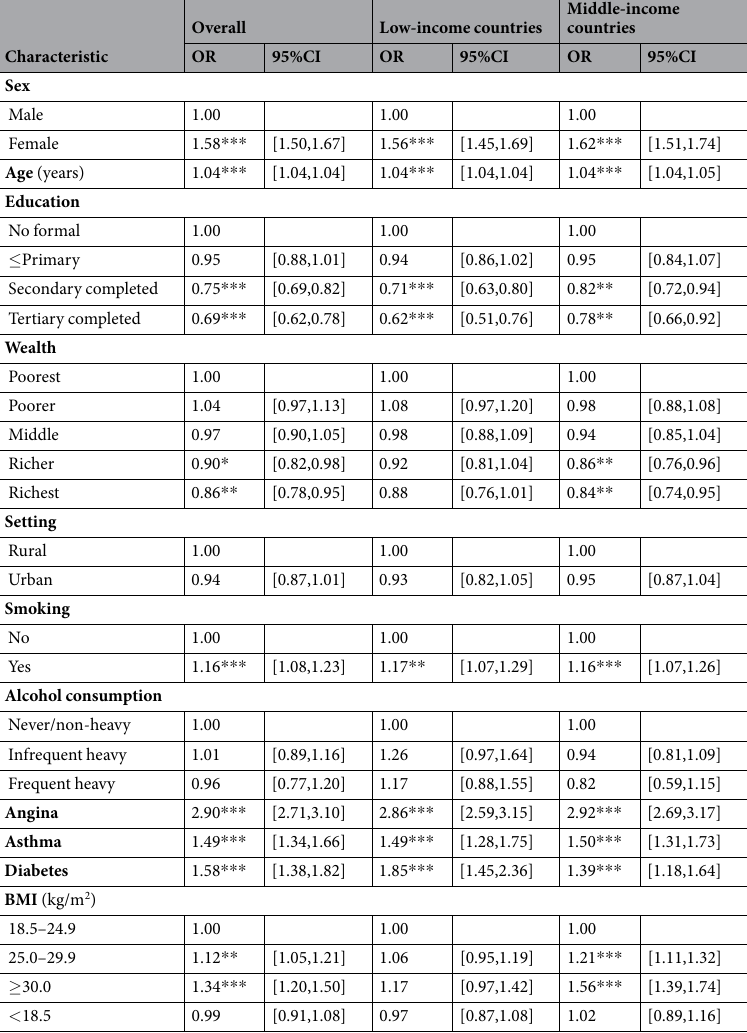
Table 3. Correlates of arthritis assessed by multivariable binary logistic regression analysis. Abbreviation: OR odds ratio; CI confidence interval; BMI Body mass index. The models are adjusted for all variables in the table and country. Turkey is not included in the regression analyses as it lacked information on education. * p < 0.05, ** p < 0.01, *** p <